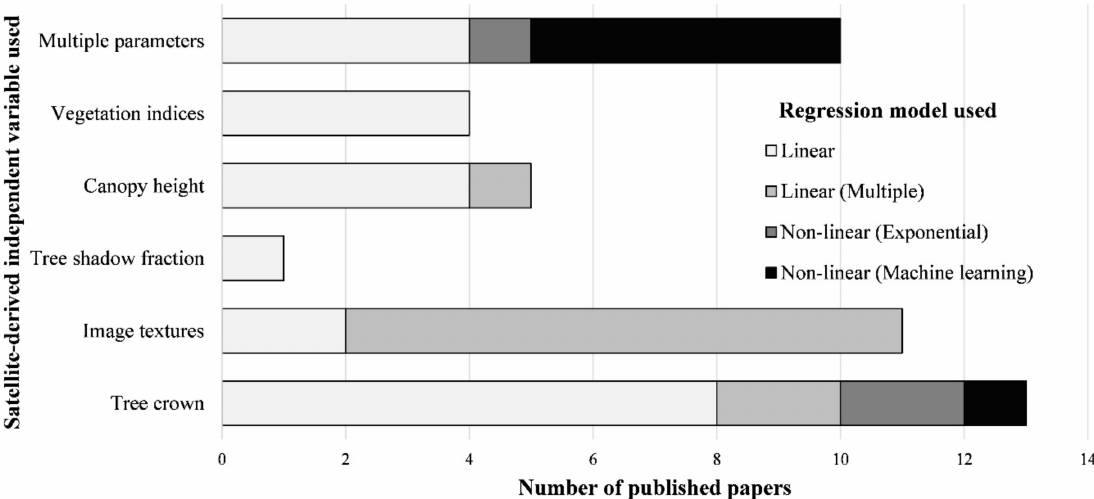
Figure 2. Summary of satellite-derived independent variables used, along with the regression model used, for the estimation and mapping of forest AGB using high-resolution optical satellite imagery published in 44